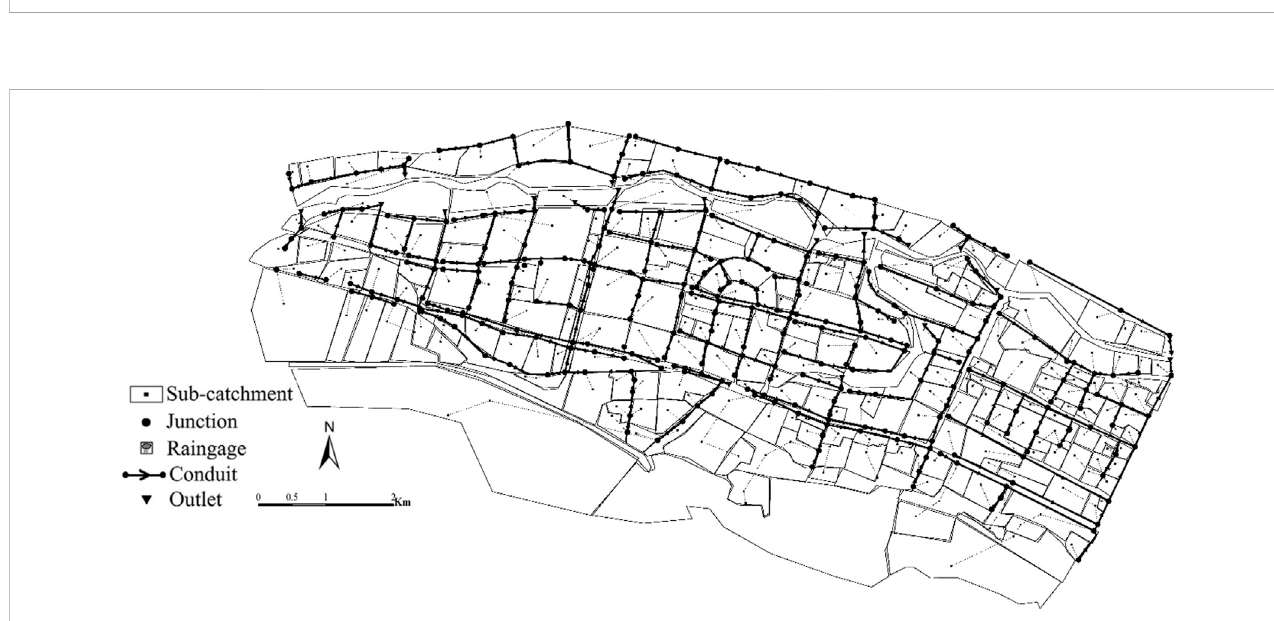
FIGURE 4 SWMM model generalization of the study